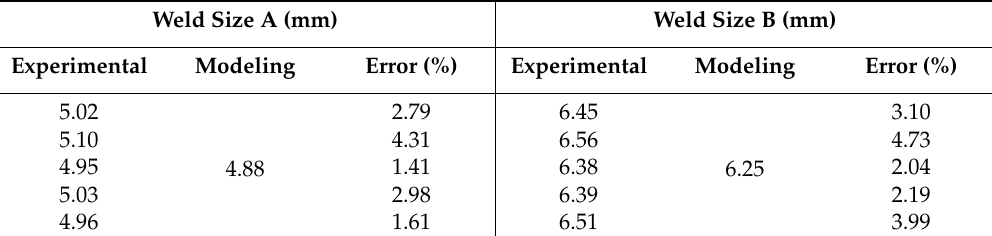
Figure 12. Comparison of modeling and experimental results in the weld-bonding process. Table 3. Comparison of the weld sizes between the modeling and experimental results. Weld Size A (mm) Weld Size B (mm) Experimental Modeling Error (%) Experimental Modeling Error (%)